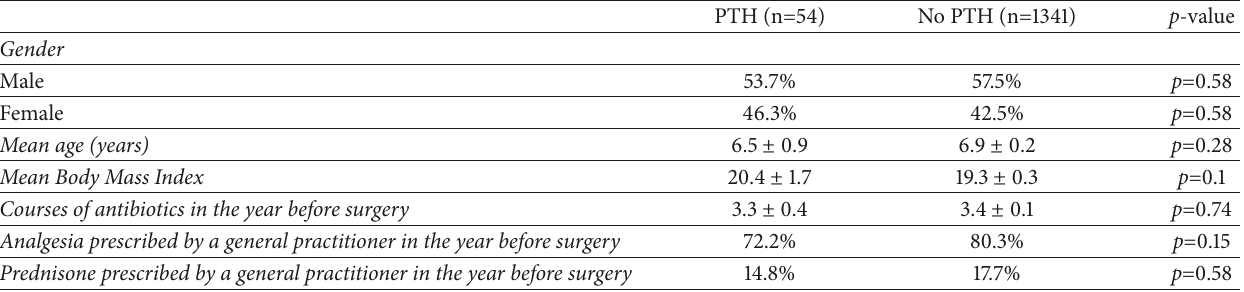
Table 1: Demographic and preoperative prescription data for children who underwent tonsillectomy in the public sector: PTH versus no